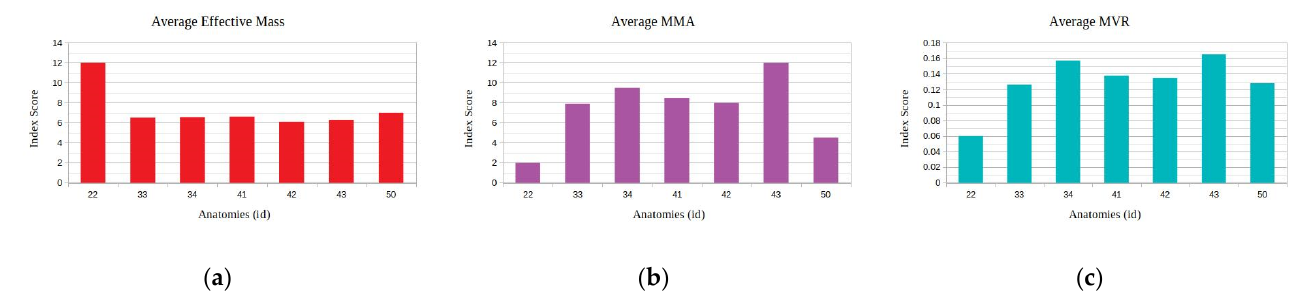
Figure 23. Derived mean index value for the selected performance indices under the available met- amorphic structure anatomies, for Task 4 (( a ) with respect to the Average Effective mass index, ( b ) with respect to the Average MMA index and ( c ) with respect to the average MVR index).